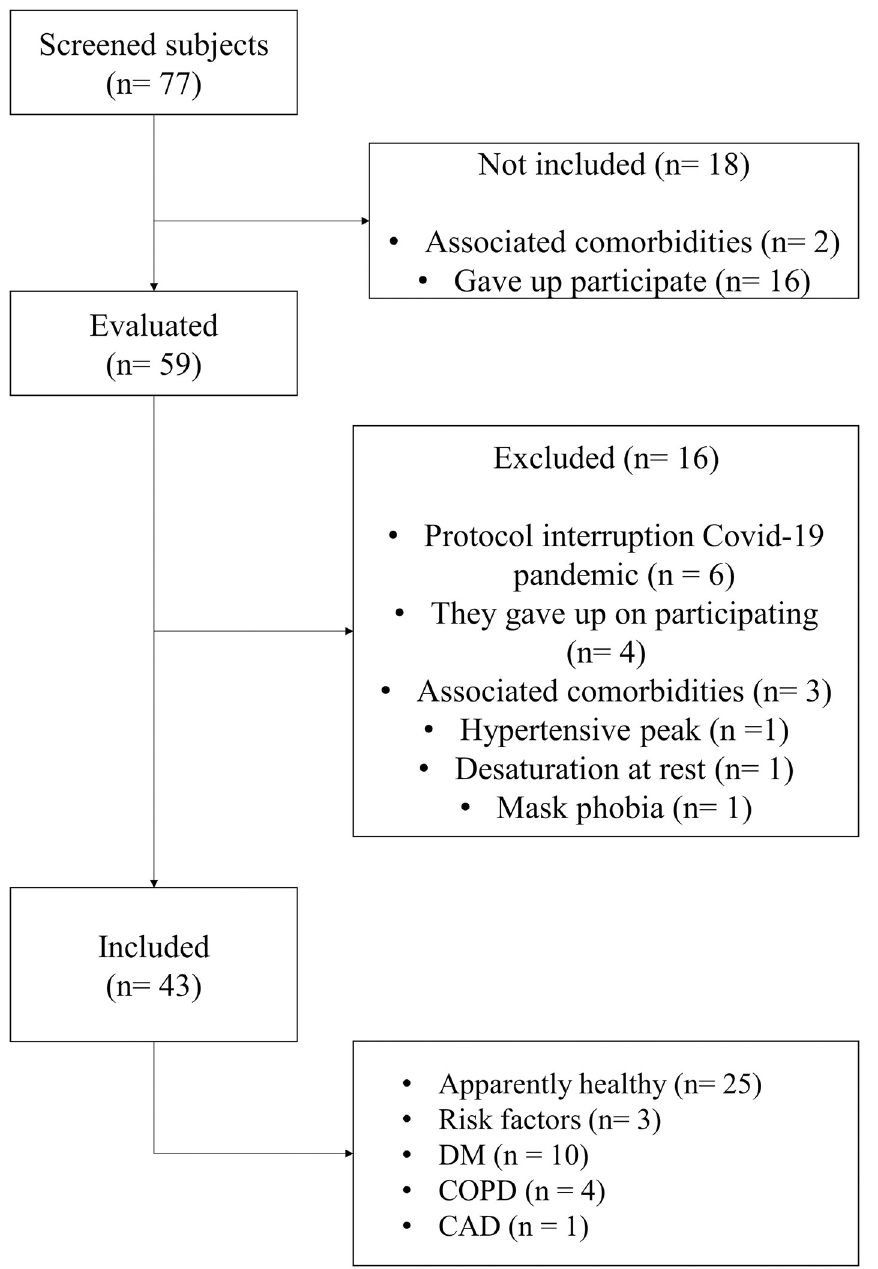
Fig 3. Flowchart of screening, evaluation and inclusion and exclusion criteria for the study. This flow diagram illustrates the sample size and the volunteer characteristics. DM: diabetes mellitus; COPD: chronic obstructive pulmonary disease; CAD: coronary artery